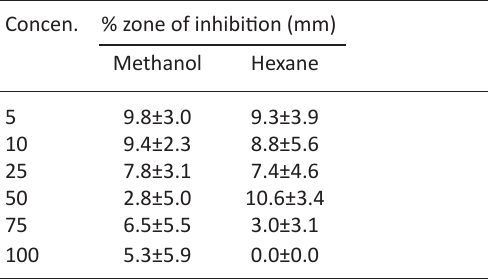
Table 10. Mean and Standard deviation for methanol and hexane extracts for C. cinereum at 100%, 75%, 50%, 25%, 10% and 5% concentration against K. pneumoniae Concen. % zone of inhibition (mm)